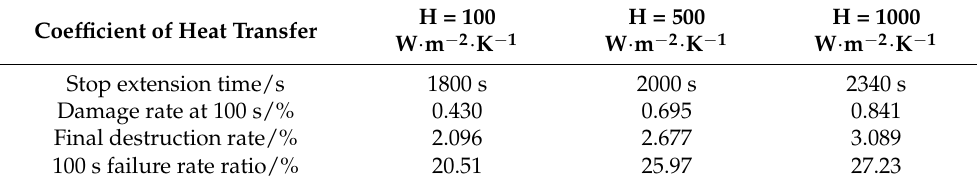
Table 3. Failure rate of rocks with different heat exchange coefficients.